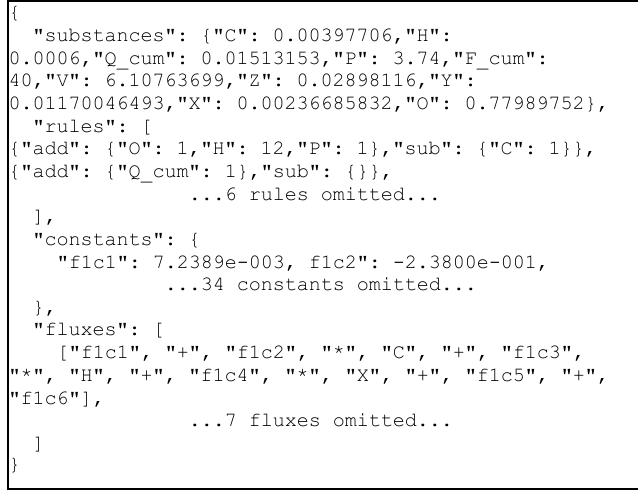
Fig. 5. MP grammar of NPQ encoded in JSON data structure (some parts omitted in order to save space).